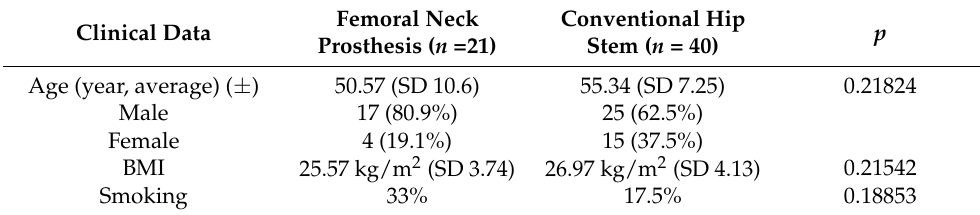
Table 1. Clinical characteristics of the studied